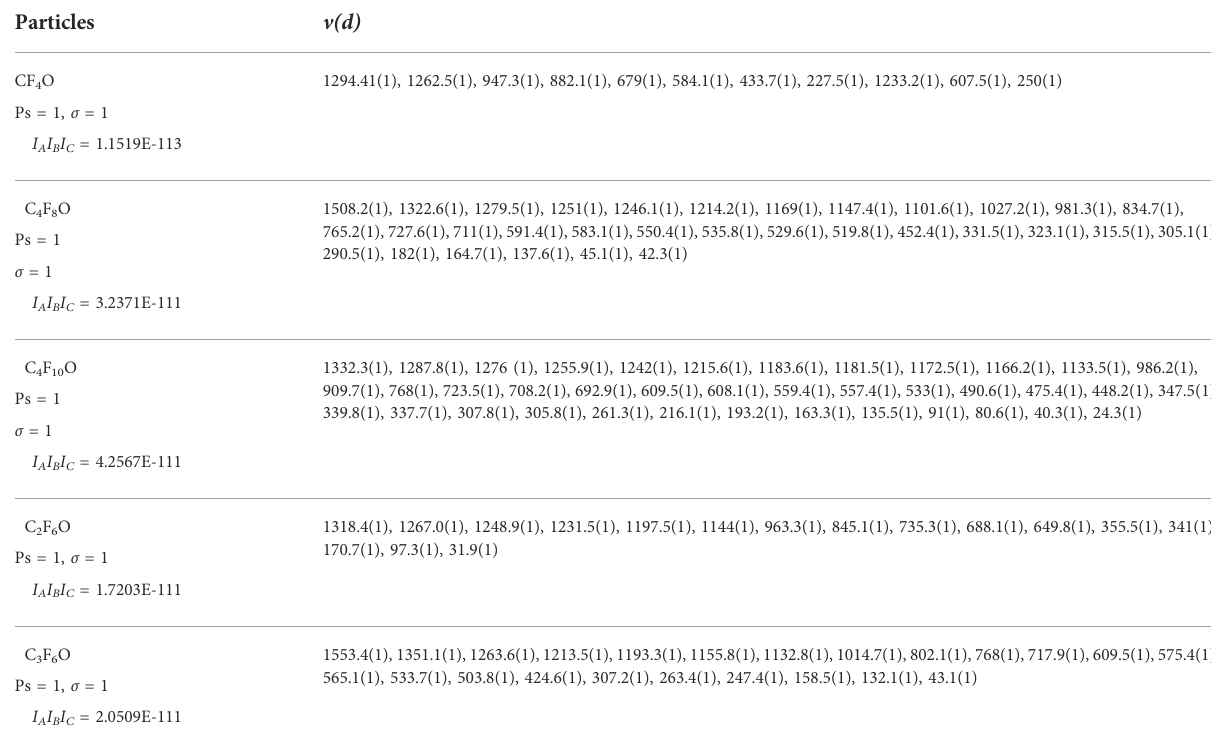
TABLE 1 Calculated values of vibration parameters and rotation parameters of polyatomic